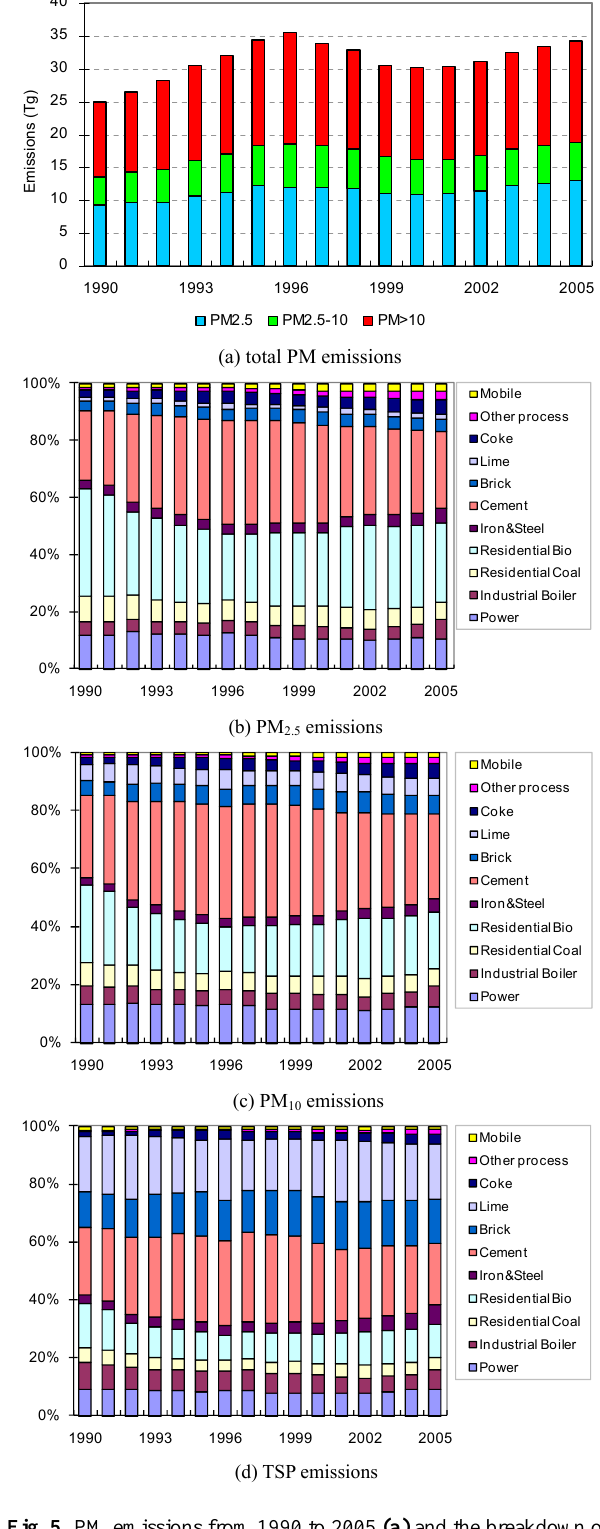
Fig. 5. PM emissions from 1990 to 2005 (a) and the breakdown of emissions of (b) PM 2 . 5 , (c) PM 10 and (d) TSP by different